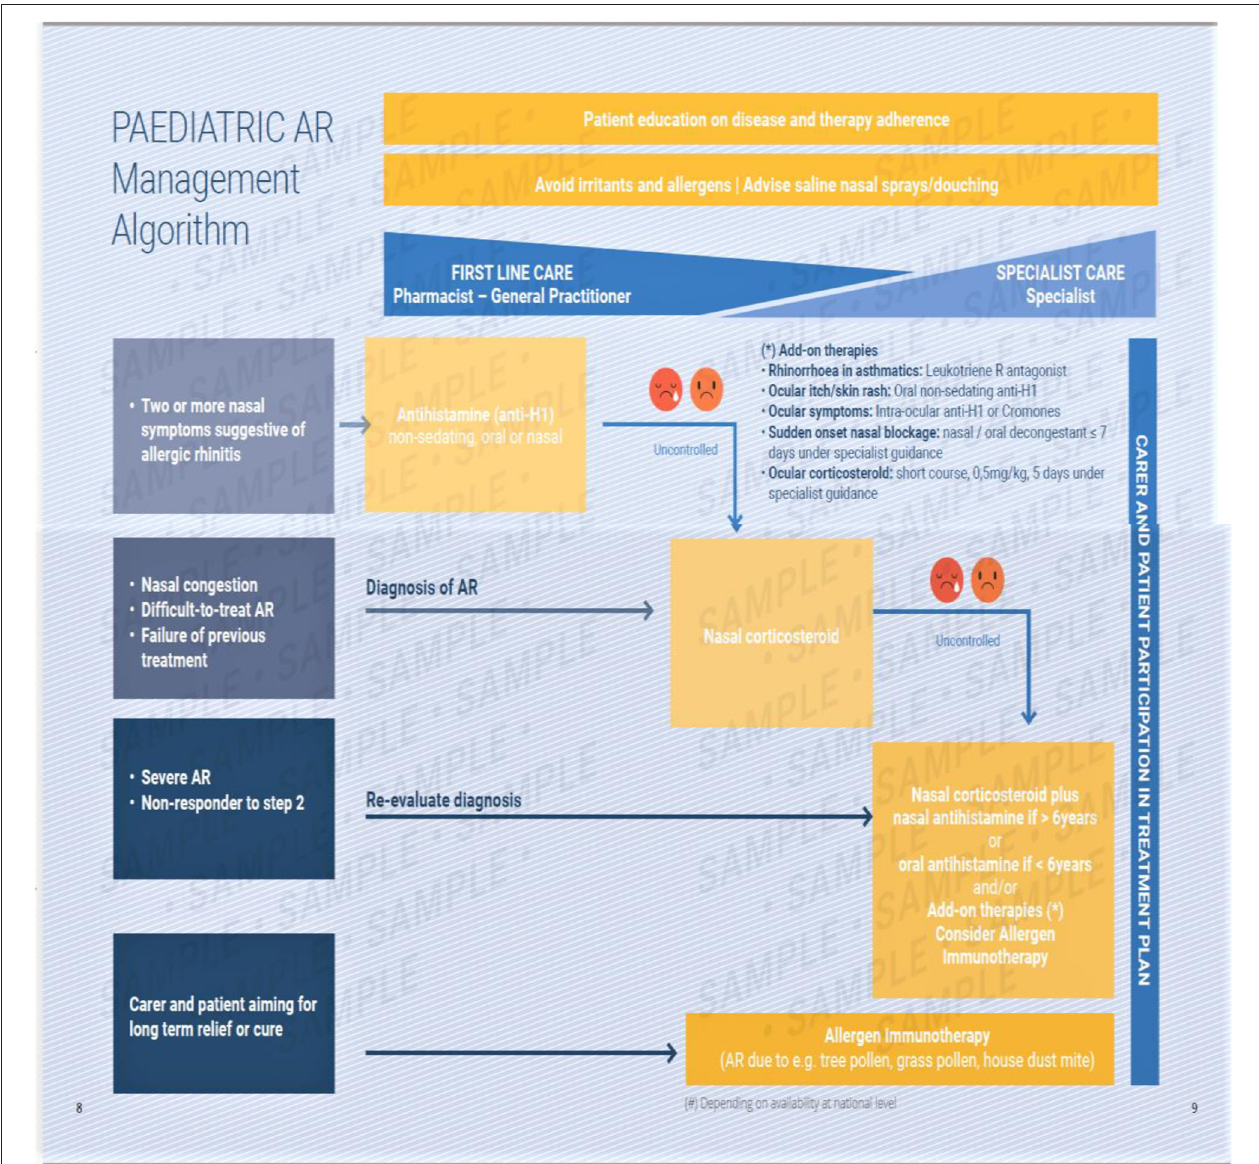
FIGURE 5 | The EUFOREA management algorithm for pediatric allergic rhinitis. This includes measures common to all sufferers and provides a graduated guide to therapy based upon symptoms and their response to therapy. A pictorial visual analog scale is suggested, with poor control being indicated by the two sad faces shown. This requires